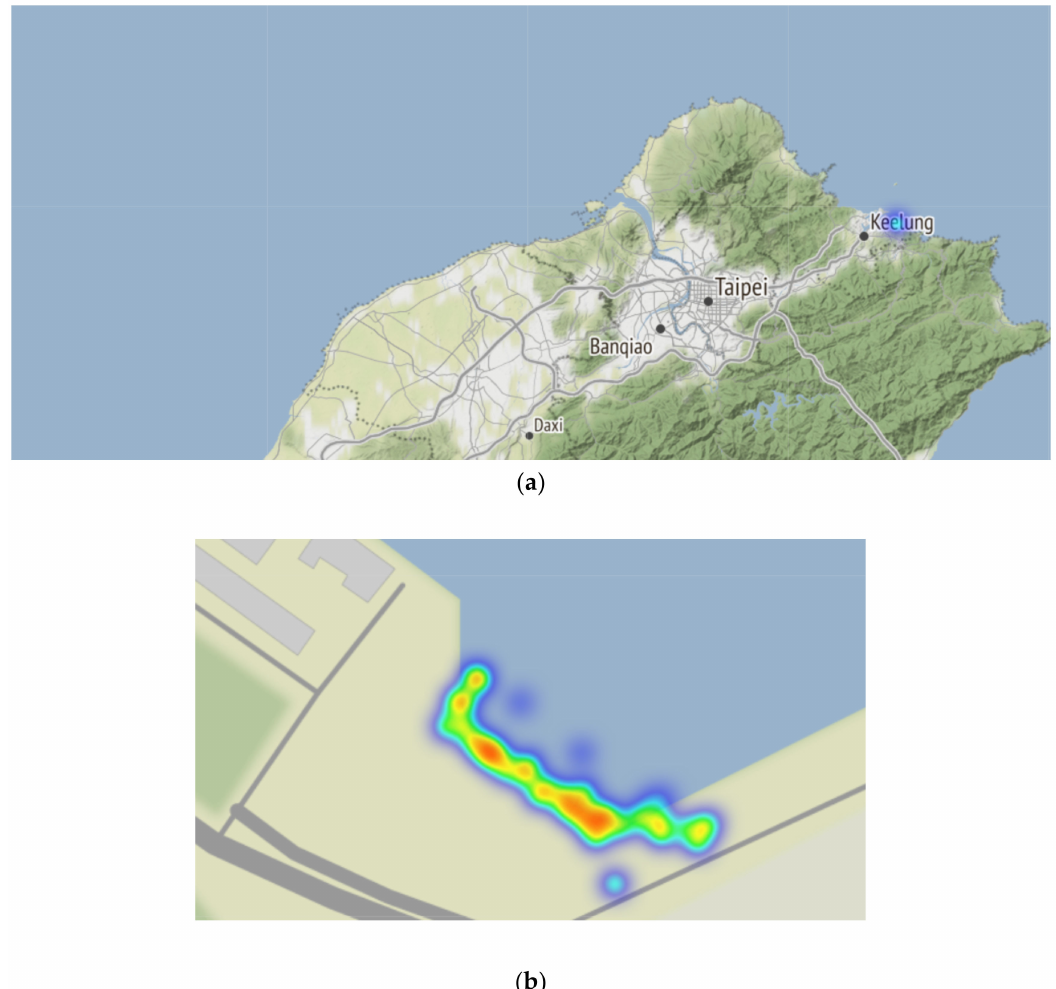
Figure 17. Trash map: the heatmap of trash pollution areas. ( a ) A heatmap of trash pollution area (north of Taiwan). ( b ) A zoom in heatmap of trash pollution area (Badouzi fishing